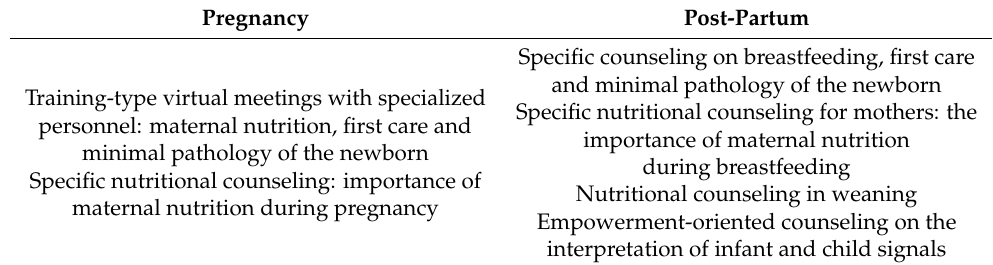
Table 3. Telemedicine in pregnancy and in the first 1000 days: priorities for future development. Pregnancy Post-Partum